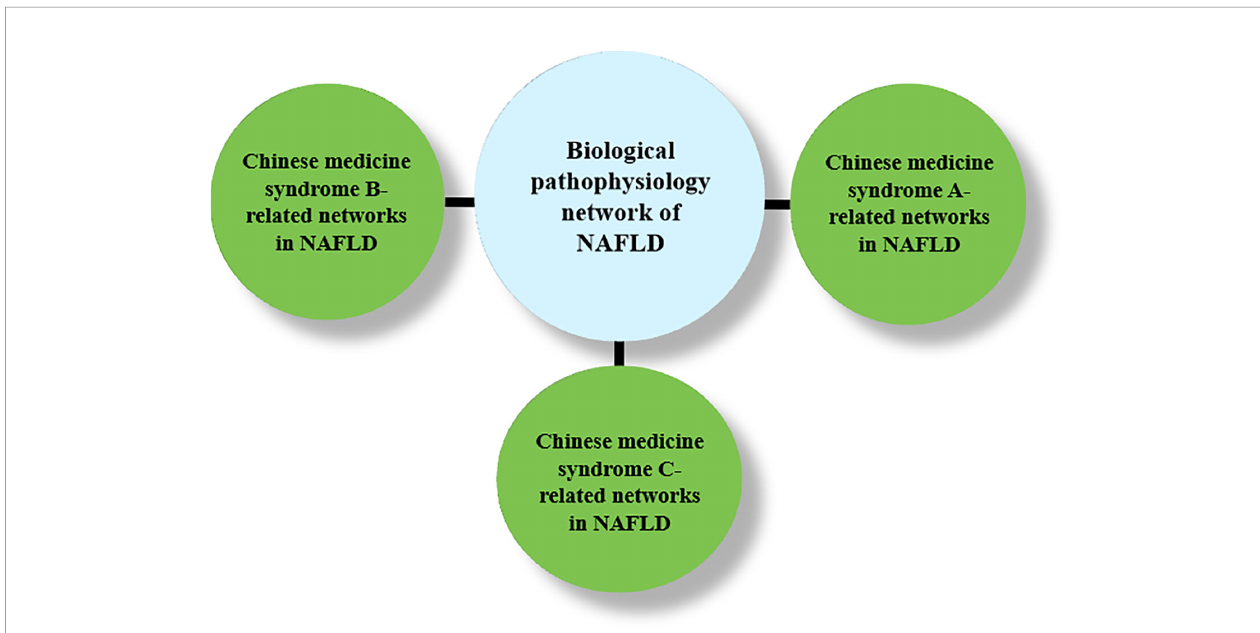
FIGURE 5 | A schematic diagram of drug discovery for NAFLD treatment based on TCM-based network